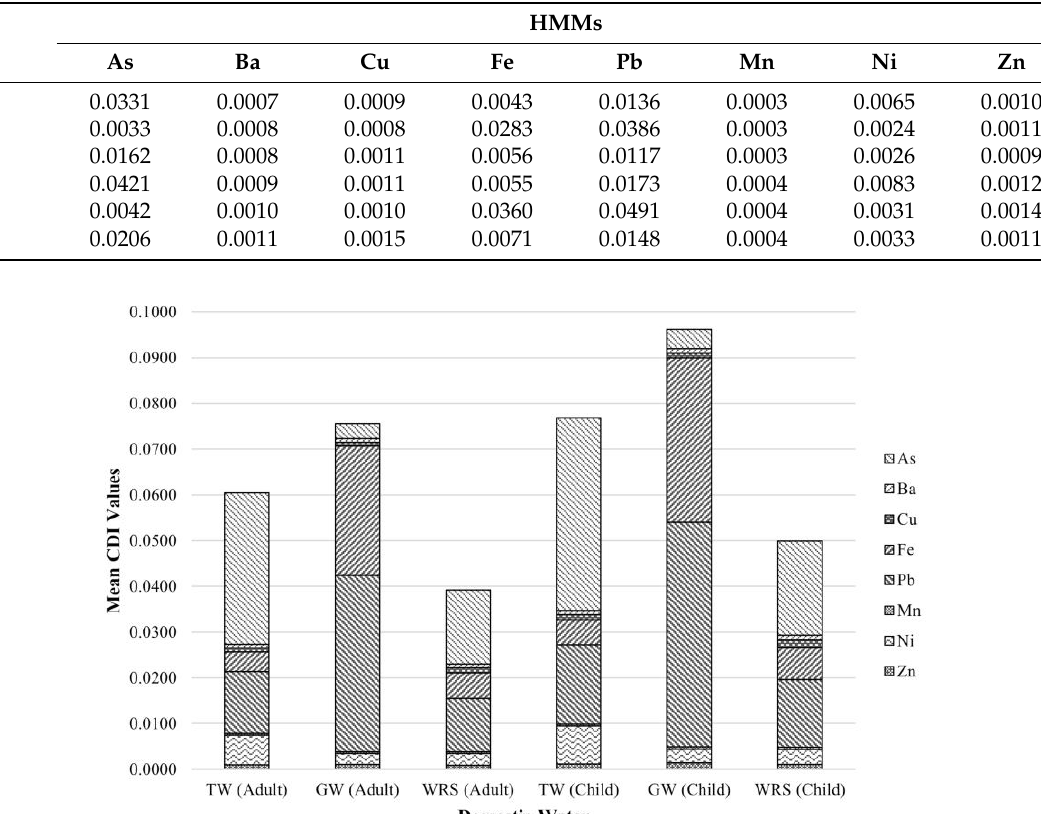
Table 8. The mean CDI of metals (mg/L) through oral route from water.